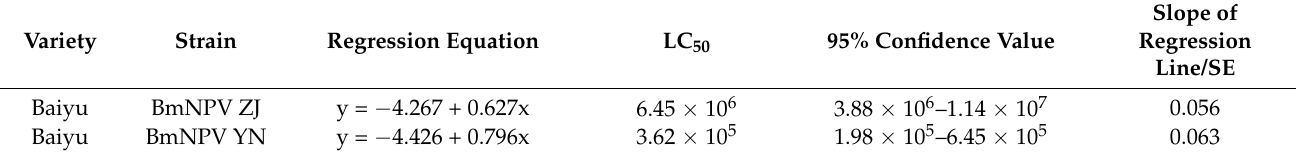
Table 3. Comparison of virulence of BmNPV ZJ and BmNPV YN in Baiyu larvae.